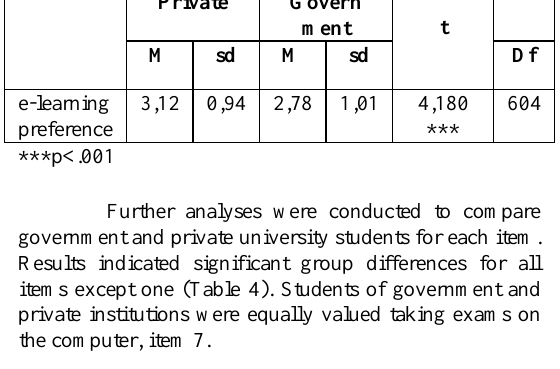
Table 4. t-test results for government and private